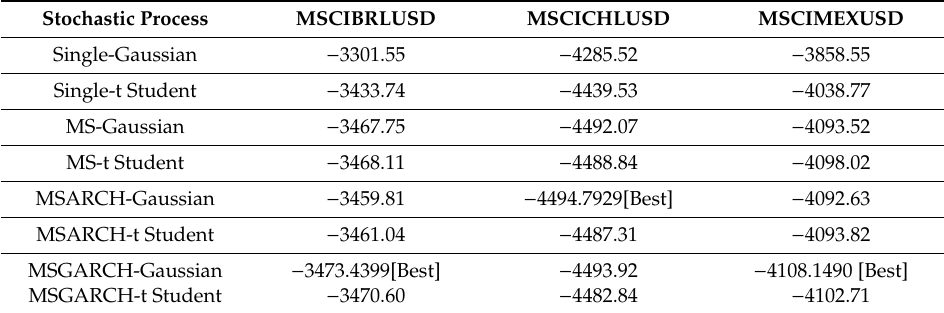
Table 3. Summary of fitting the di ff erent MS models used as candidates for the stochastic process in each index.